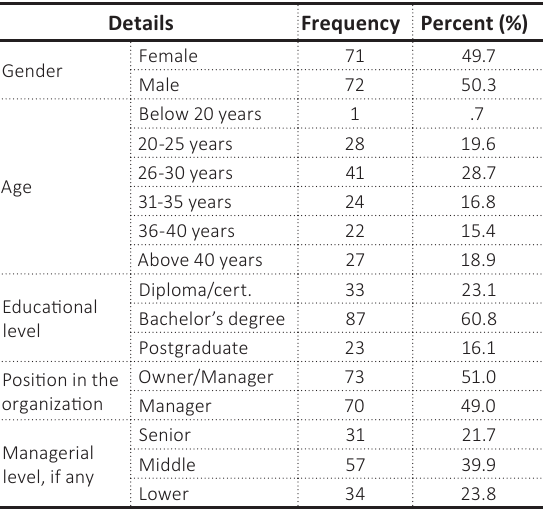
Table 1. Socio-demographic profile of respondents